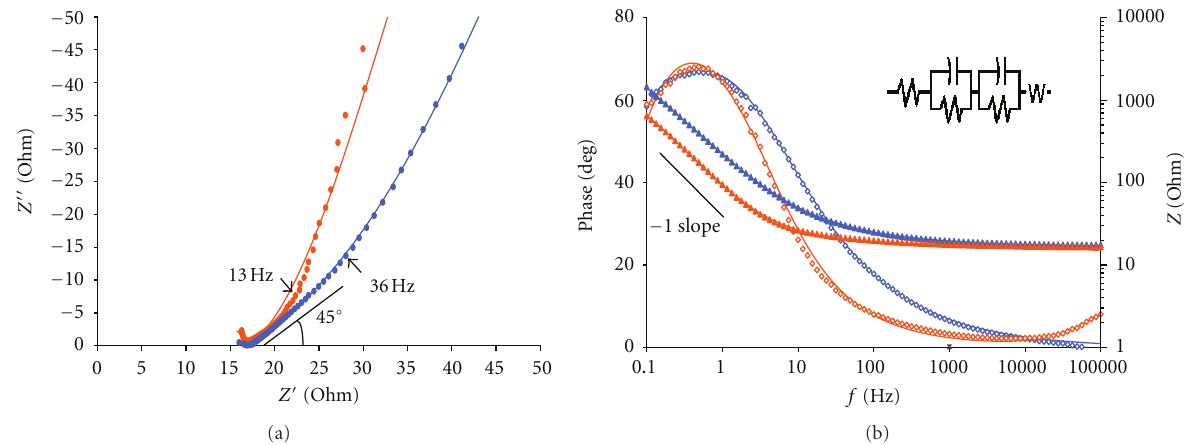
Figure 3: EIS results under irradiation: (a) Nyquist plots; (b) phase angle (empty symbols) and modulus (solid symbols) Bode plots; E = OCV, λ = 365nm. Blu symbols: in absence of glycerol. Orange symbols: in presence of glycerol. Solid lines refer to the model fit.